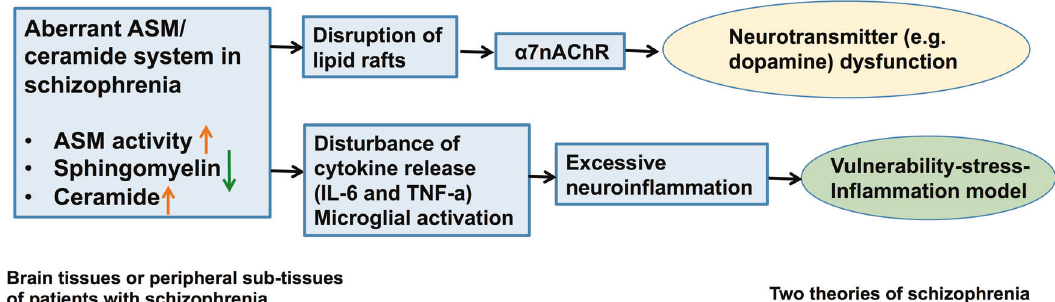
Fig. 2 Hypothetical role of the acid sphingomyelinase/ceramide system in schizophrenia. Aberrant ASM activity and abnormal ceramide and sphingomyelin levels were observed in the brain and peripheral sub-tissues (red blood cells and epidermis) of patients with schizophrenia. ASM/ceramide system dysfunction may hypothetically perturb neurotransmission in the dopamine (DA) model through the desensitization kinetics of the alpha 7 nicotinic acetylcholine receptor ( α 7nAChR), and promote in fl ammation by upregulating interleukin-6 production and TNF-alpha signaling in the vulnerability-stress-in fl ammation model of